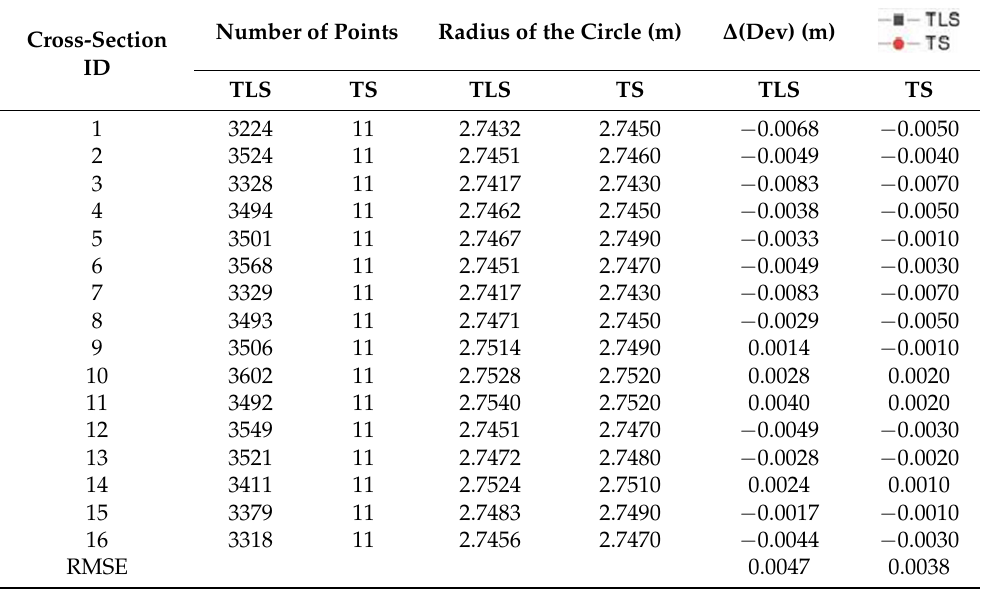
Table 1. Comparison of values obtained by different methods with the same design values.